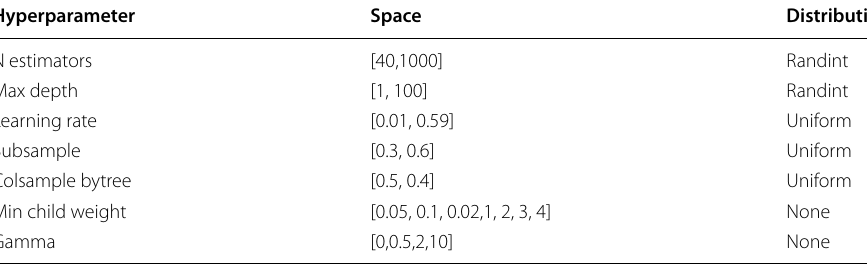
The number of nestimators and the maxdepth is determined by drawing random integers. Minchildweight and gamma are determined by drawing from a set of pre‑determined values. The remaining hyperparameters are drawn from uniform distributions